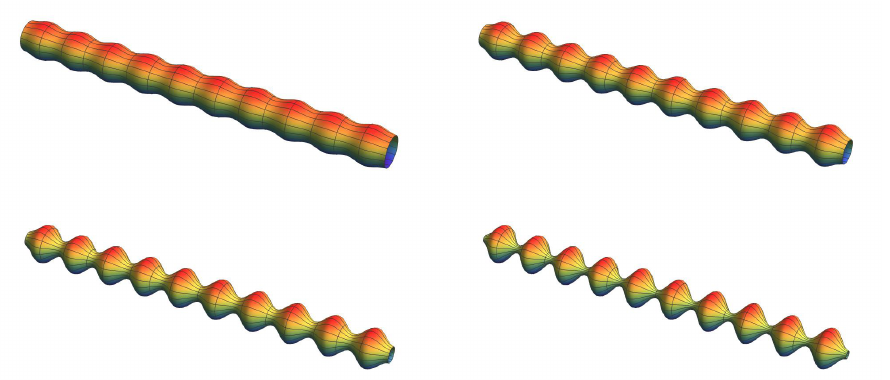
Figure 3. Surface of revolution of a rod with a cosinusoidal corrugations mimicking a chain of spheres connected by necks. In this figure, R 0 was set to 0.05 and n = 10. From upper left to lower right, α varies from 0.2 to 0.4, to 0.6 to